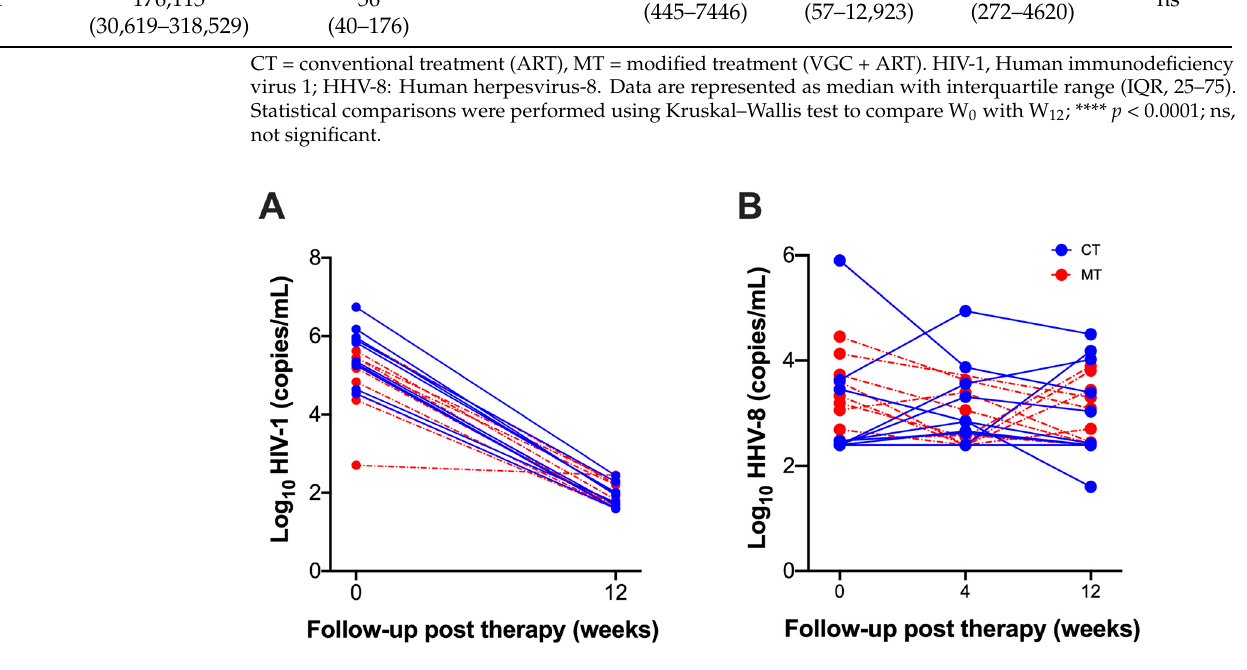
Figure 3. Viral loads of HHV-8 and HIV-1 in KS/HIV patients across follow-up. The viral load of